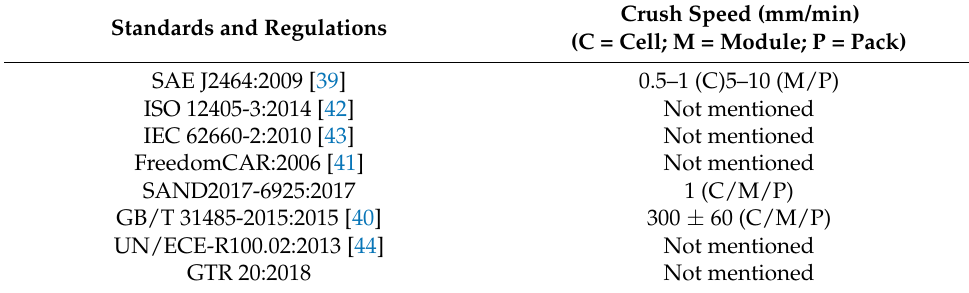
Table 4. Crush speed as per different standards and